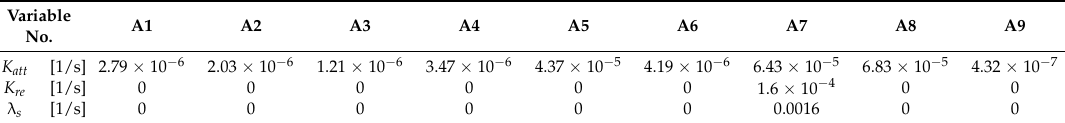
Table 3. Fitting parameters of the experiments in each